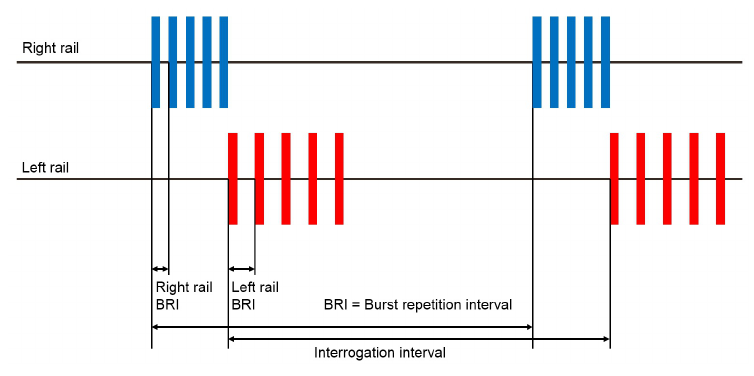
Figure 15. Block diagram of the UBRD [53].